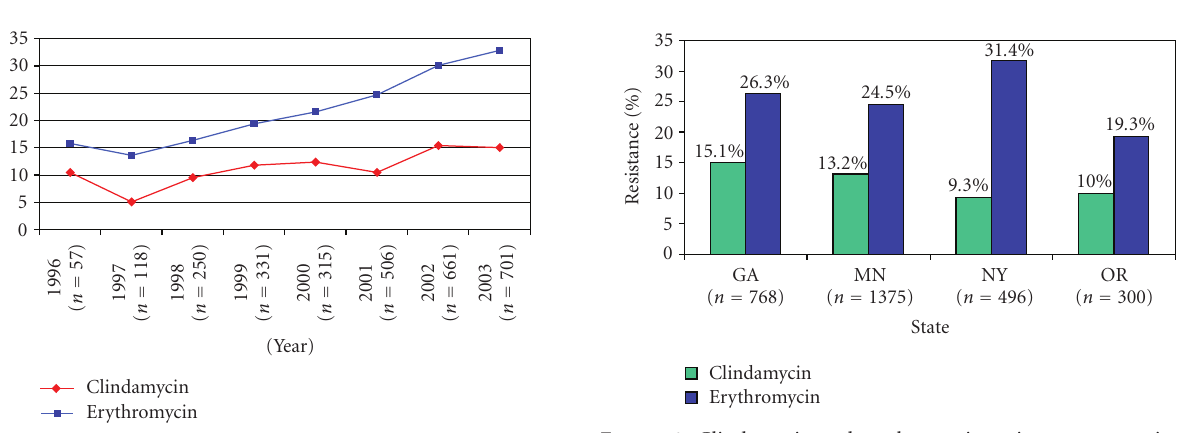
Figure 1: Clindamycin and erythromycin resistance among inva- sive Group B streptococci isolates by year ( n = 2937 isolates).